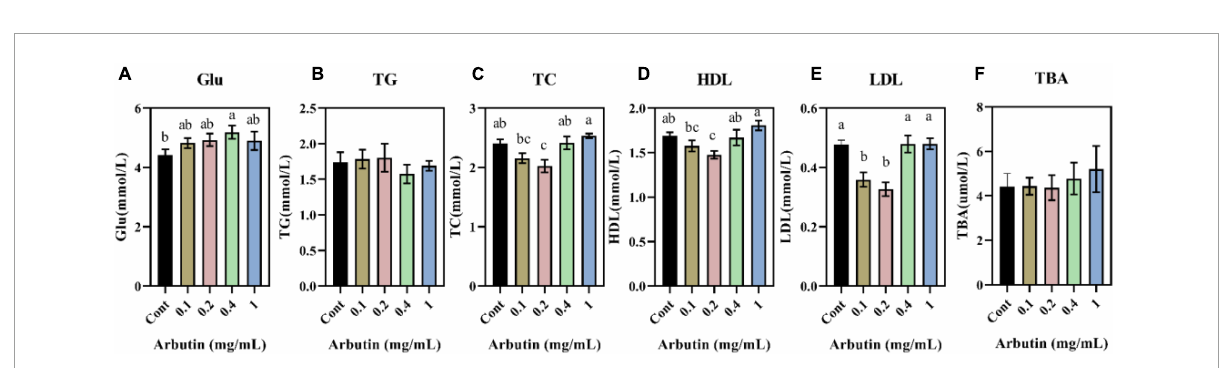
FIGURE2 Effects of oral arbutin on serum lipids. Glucose (A) , total triglycerides (B) , total cholesterol (C) , high-density lipoprotein (D) , low-density lipoprotein (E) , and total bile acid (F) ( n = 10). Values are presented as the means ± SEMs. Differences were assessed by one-way ANOVA and denoted as follows: a and b indicate significant differences in each